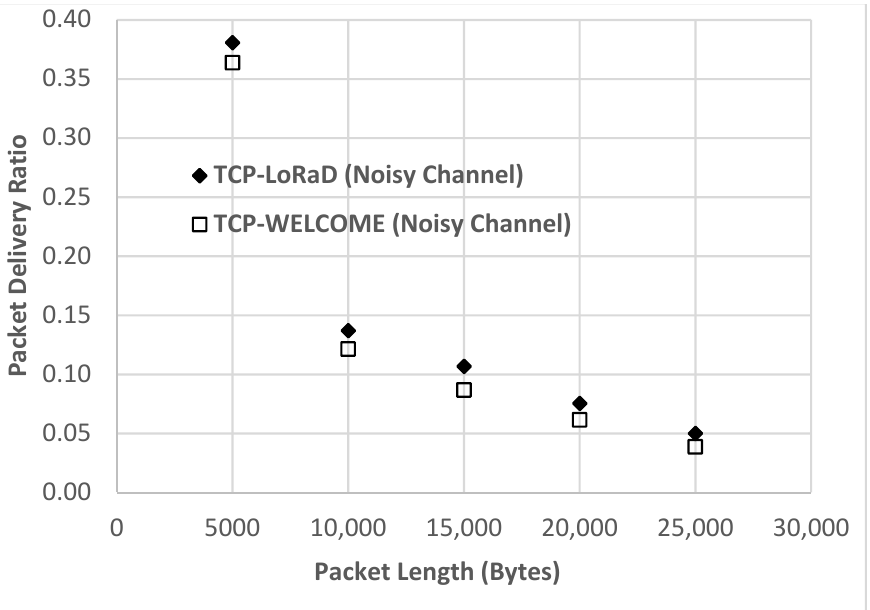
Figure 14. End-to-End delay versus Packet Length in a noisy channel. Comparison of TCP-LoRaD and TCP-WELCOME.